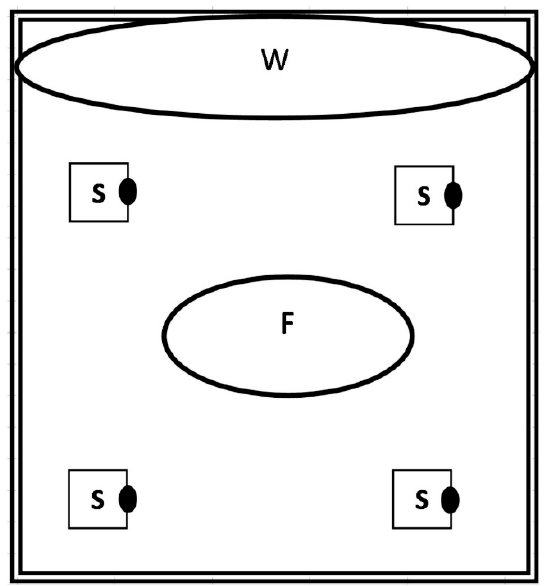
Figure 1. Litter sampling in each pen. Waterer (W), feeder (F), and sampling location